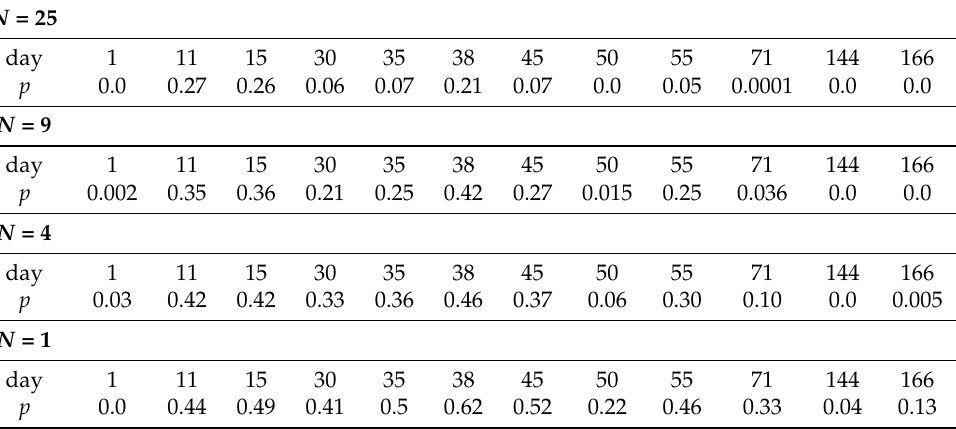
Table 6. The probability of drawing a wrong conclusion about the slug population in the Stoney Lawn field. N is the number of sampling